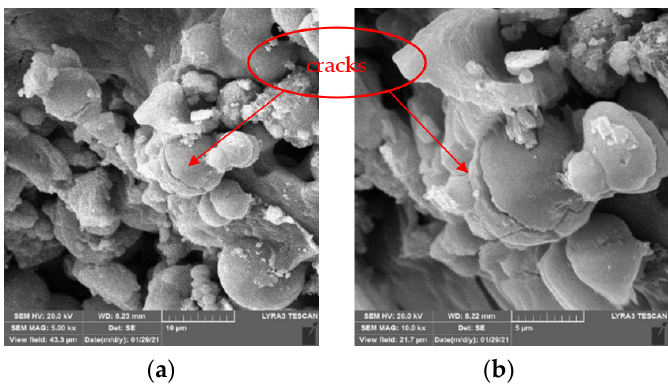
Figure 10. SEM images of CaC 2 O 4 crystals from upper layer. ( a ) 5 kx. ( b ) 10 kx.